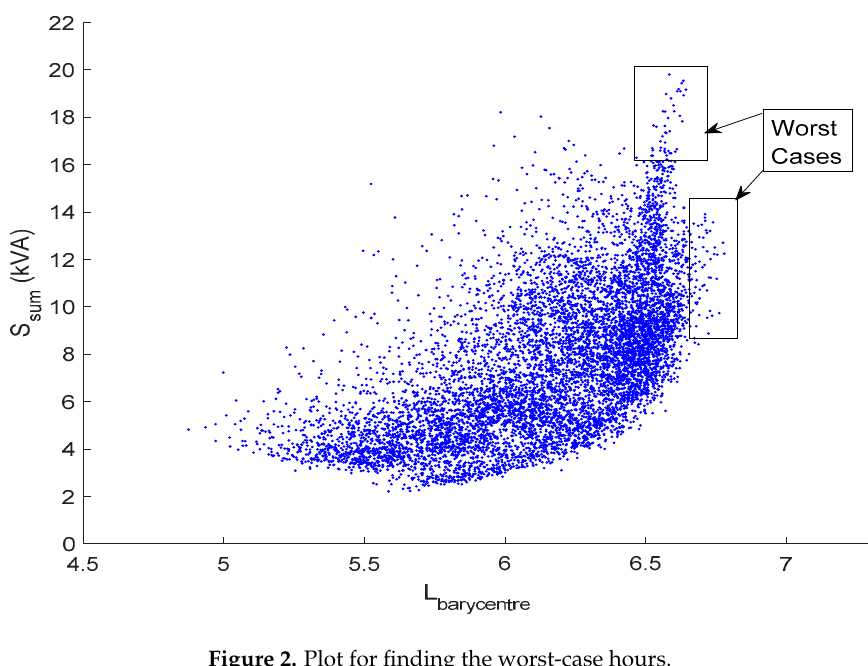
Figure 2. Plot for finding the worst-case hours.